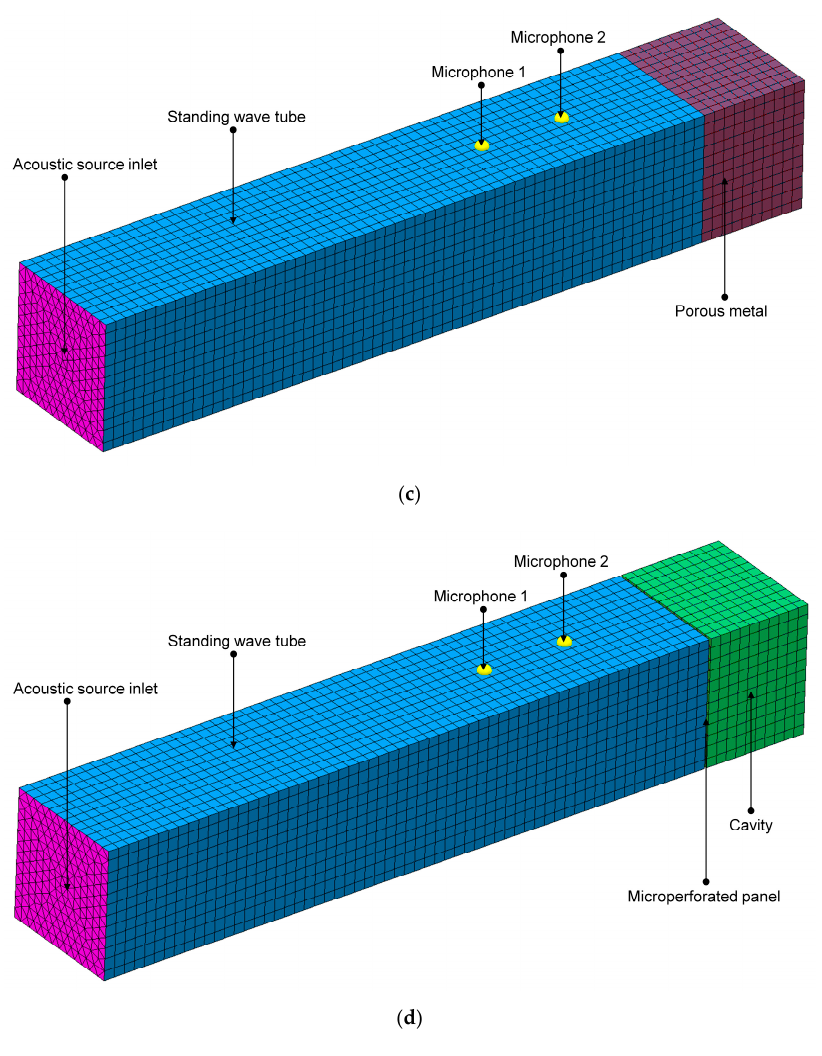
Figure 3. The finite element simulation models for sound absorbers constructed in the virtual acoustic laboratory. ( a ) Porous metal + cavity + microperforated panel + cavity; ( b ) Microperforated panel + cavity + porous metal + cavity; ( c ) Porous metal + cavity; ( d ) Microperforated panel +